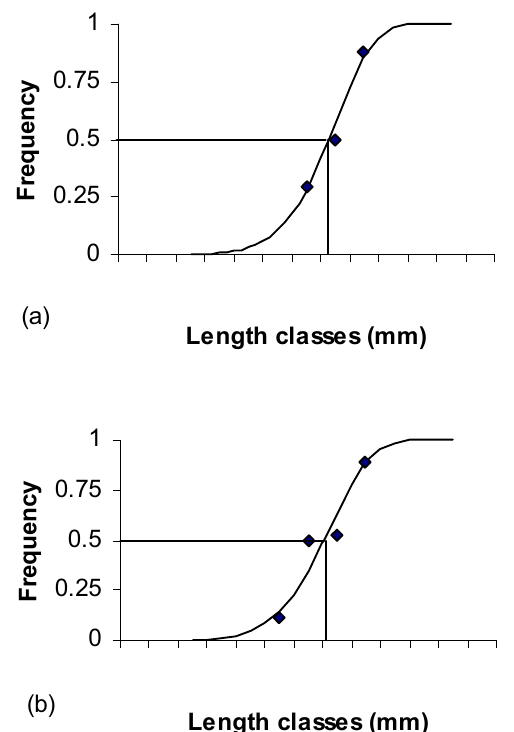
Fig. 7. Size of first gonadal maturation of Gymnotus aff. carapo in the lagoa Verde, Itapuã State Park. (a) males; (b) females.